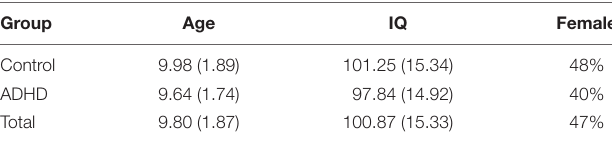
IQ, estimated IQ; ADHD, attention deficit/hyperactivity disorder group.